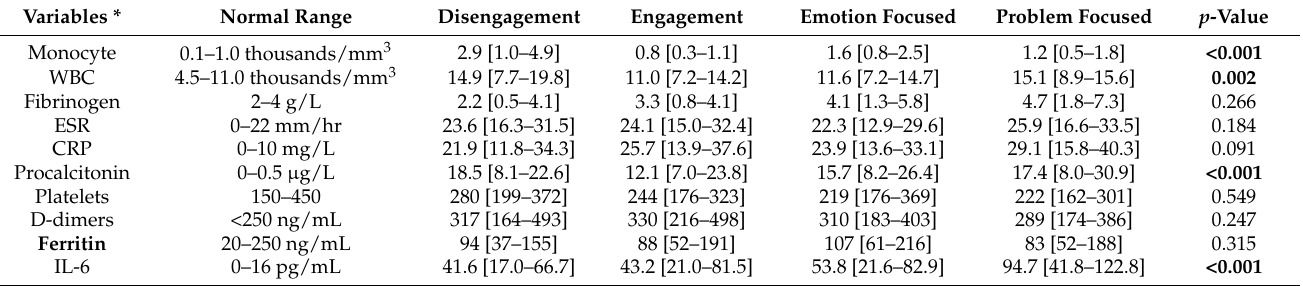
Table 6. Comparison of laboratory parameters stratified by COPE-60